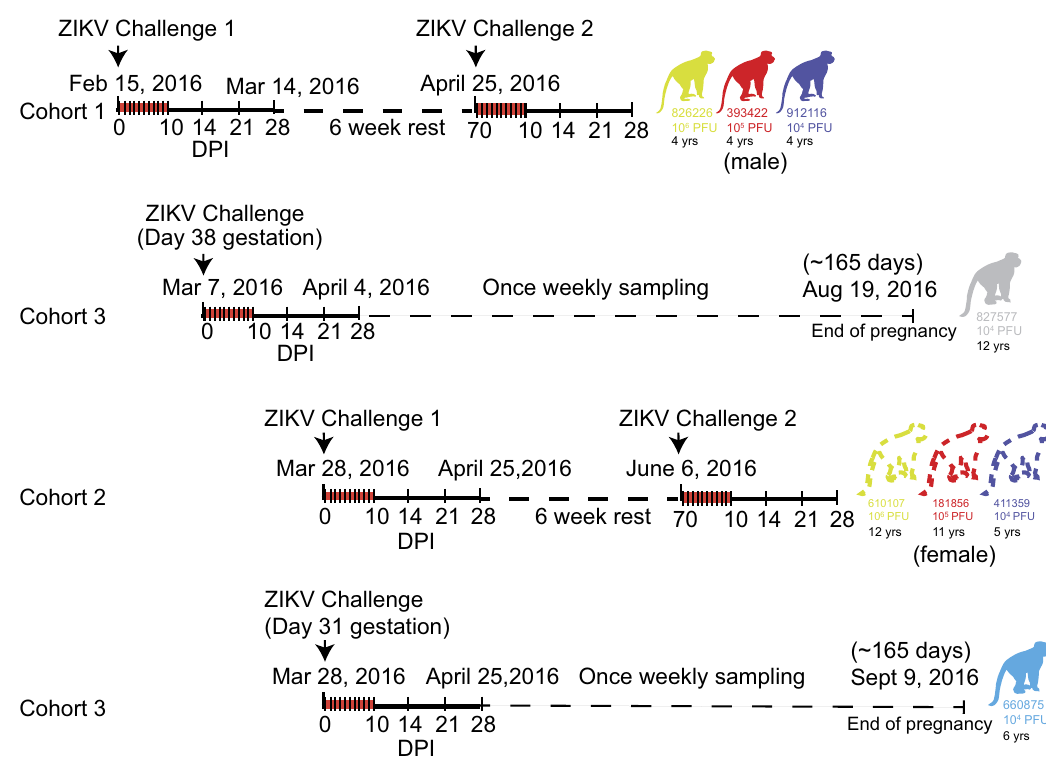
Figure 1 | Schematic representation of the timeline of infection and sampling for each animal in the presented studies. Cohort 1 received the first ZIKV challenges and was then rested for 6 weeks before a rechallenge. For all studies, samples were collected daily for 10 days and then on 14, 21 and 28d.p.i. as indicated by hashes in the timelines. Cohort 3 represents the two pregnant animals that were challenged on two different days. Both animals are currently in the once weekly sampling phase until the pregnancies come to term ( B 165 gestational days). Cohort 2 was a repeat experiment of cohort 1 that allowed for additional experiments and sample collection (for example, serum plaque infectivity) that were not feasible when we initiated cohort 1 studies. These animals are currently in a 6-week rest period and will be rechallenged on 6 June 2016. Ages of all animals are indicated under each macaque identification